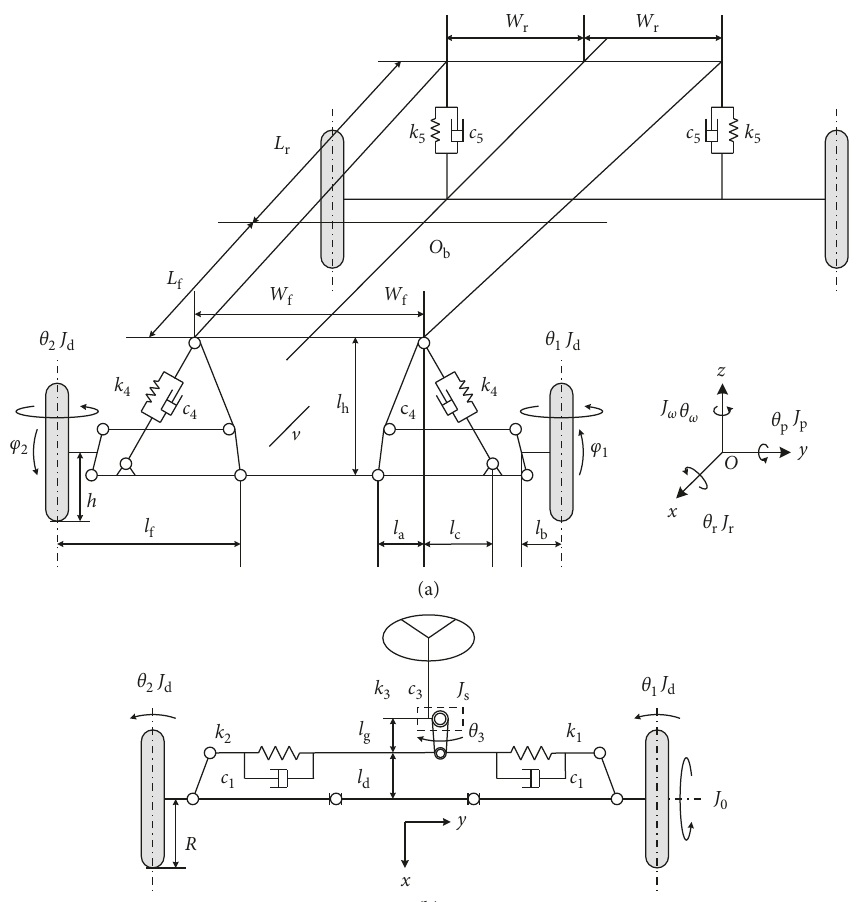
Figure 1: Mechanical model of vehicle shimmy with consideration of vehicle body. (a) Three-dimensional view. (b) Vertical view of steering